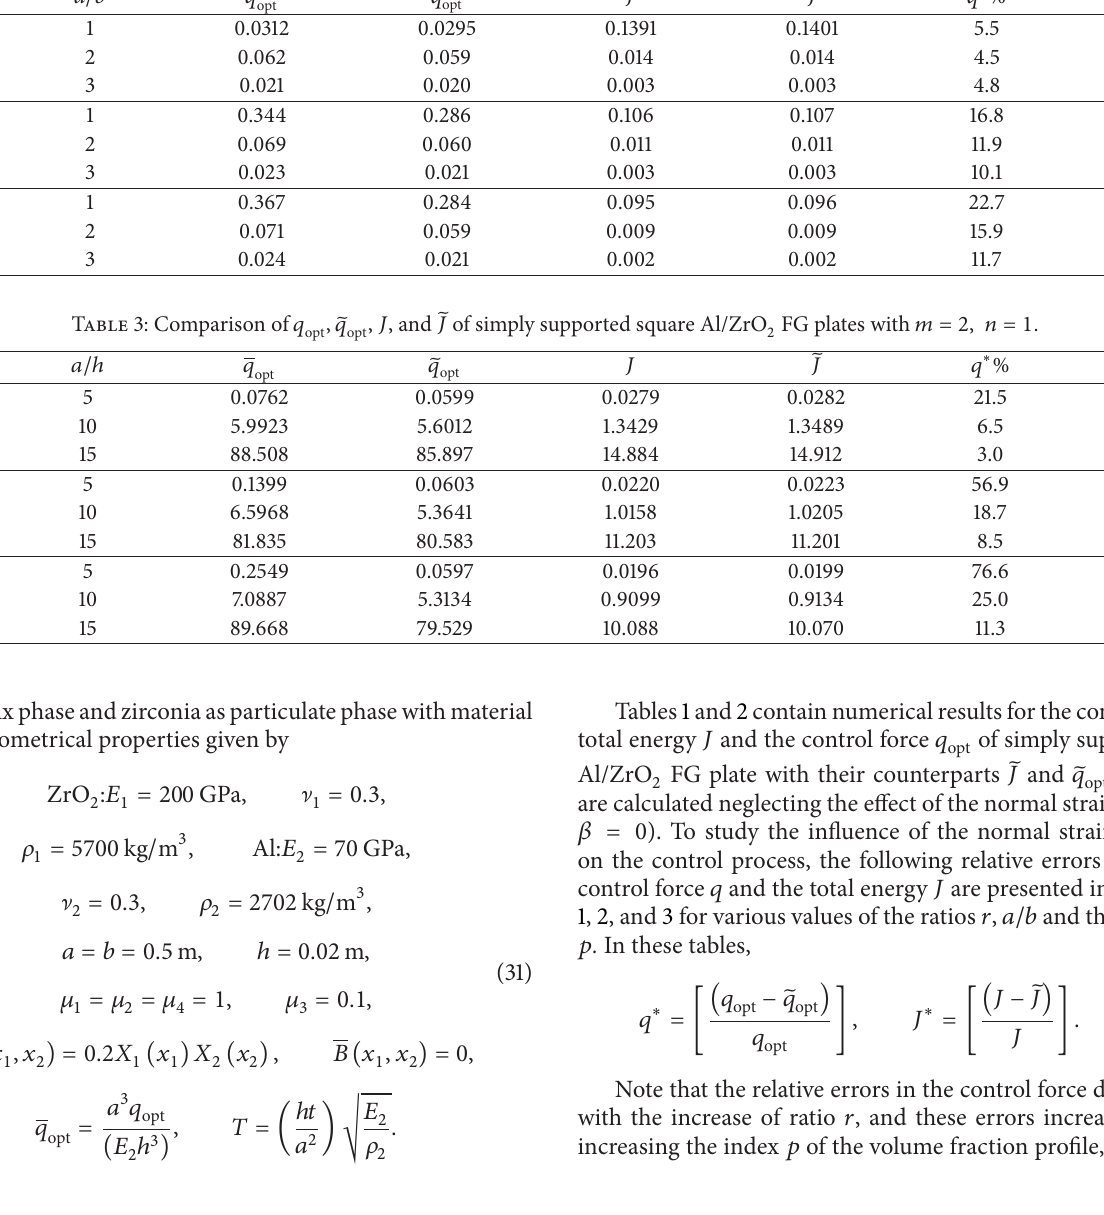
Table 2: Comparison of 𝑞